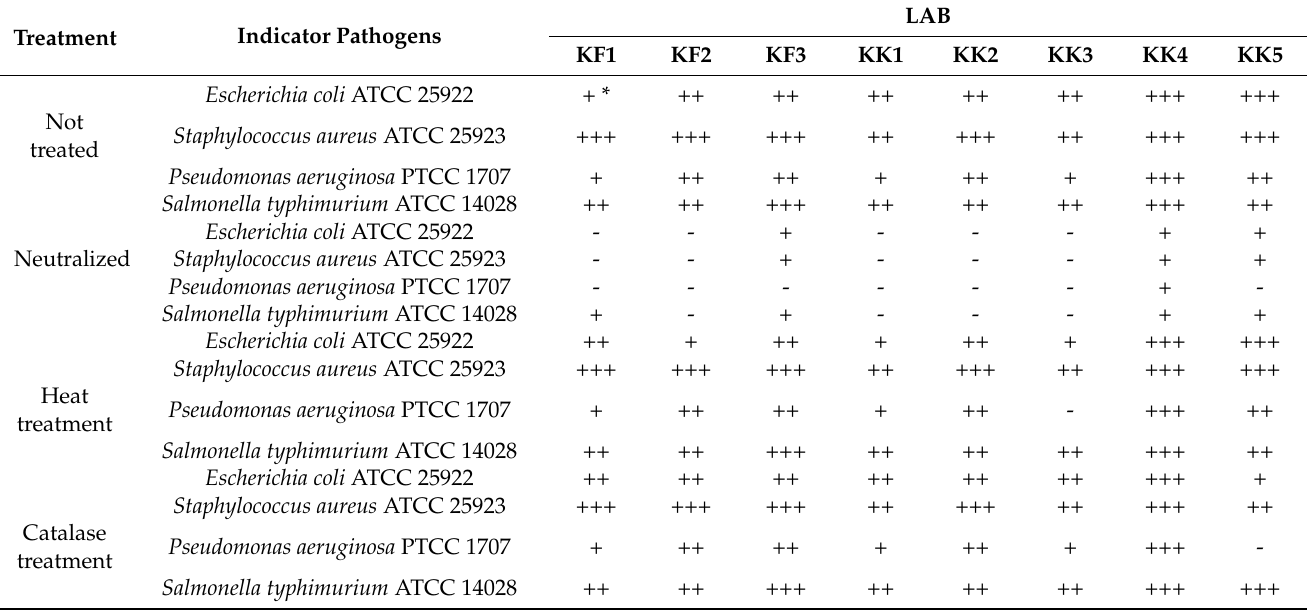
Table 6. Antimicrobial activity of LAB isolates of Abadeh (Fars) and Kalat (Razavi Khorasan) kashk